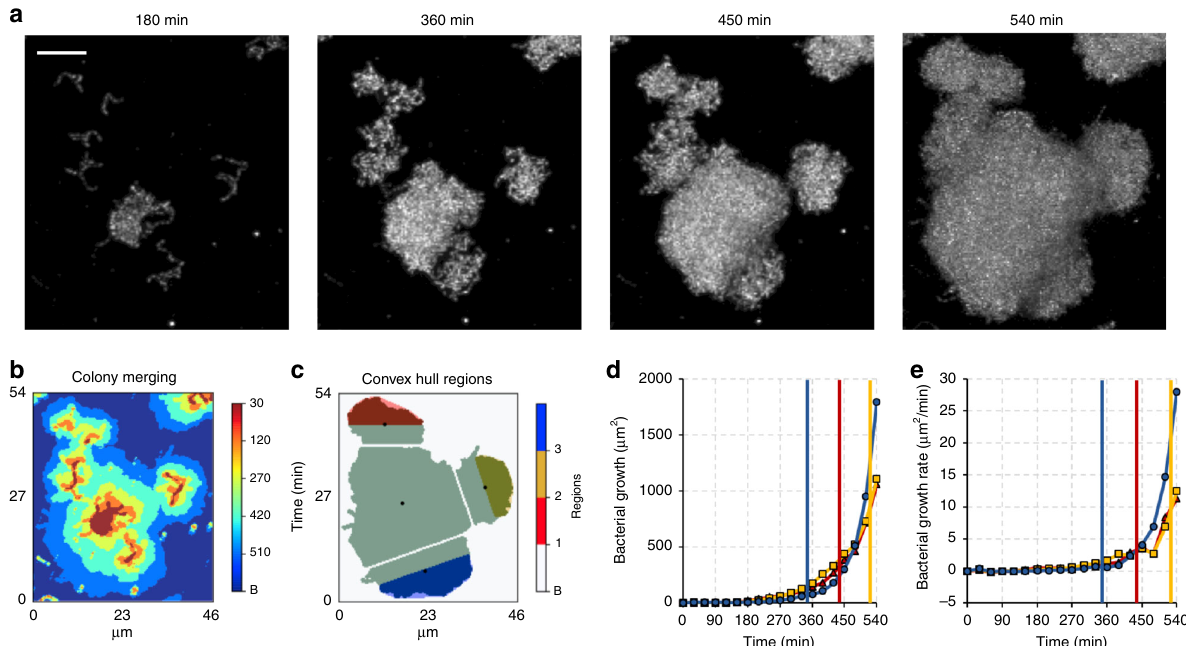
Fig. 5 Merging behavior of neighboring microcolonies. a Time-lapsed confocal images of microcolonies development. Scale bars indicate 10 µ m. b Projection map of binarized stacks from 540 min showing elements merging of multiple S. mutans microcolonies along time. c 3D scalar- fi eld analysis (represented as Z -projection) performed for each marginal element merging to the central one. The volumes were calculated for three colored regions of the marginal elements as shown in c . Black dots represent the centroids of each element at 540 min, determined on the Z -projection. d Growth and e growth rate curve of the respective marginal elements. Colored lines indicate the moment of merging to the central element ( n = 3). Source data are provided as a Source Data fi